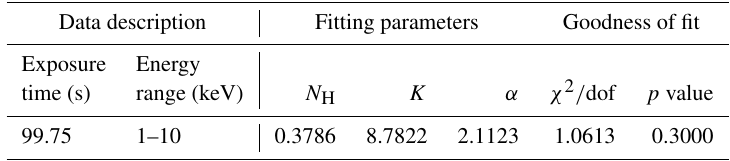
Table 2. Data description and fitting results of the unattenuated energy spectrum. Data description